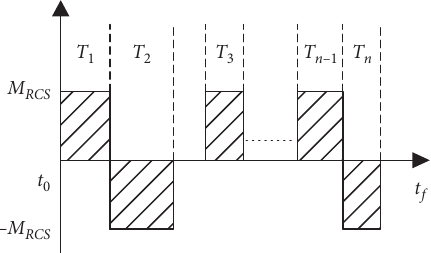
Figure 2: Schematic of RCS control torque. The horizontal axis is the working time, and the vertical axis is the control torque generated by the RCS.